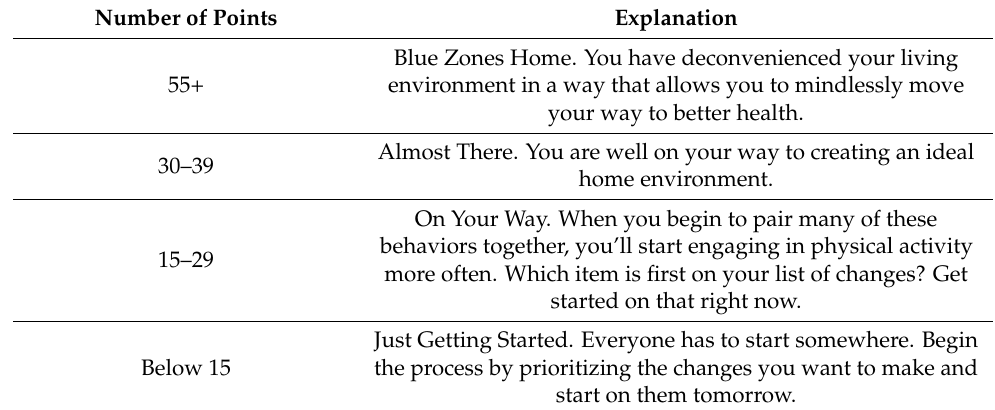
Table 2. Points related to the “Home” checklist